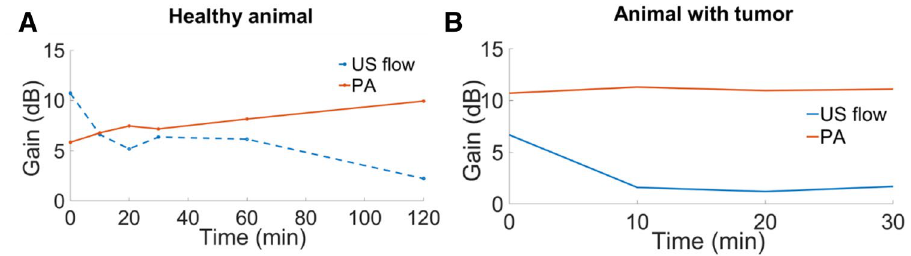
Figure 7. Enhancement of US flow and PA for healthy animal ( A ) and animal with tumor ( B ). For healthy animal ( A ), the enhancement of the contrast was evaluated at time points of immediately after the injection, 10 min, 20 min, 30 min, 1 h and 2 hs after the injection of the microdroplets. For animal with subcutaneous tumor ( B ), the enhancement of the contrast was evaluated at time points of immediately after the injection, 10 min, 20 min and 30 min after the injection of the microdroplets.